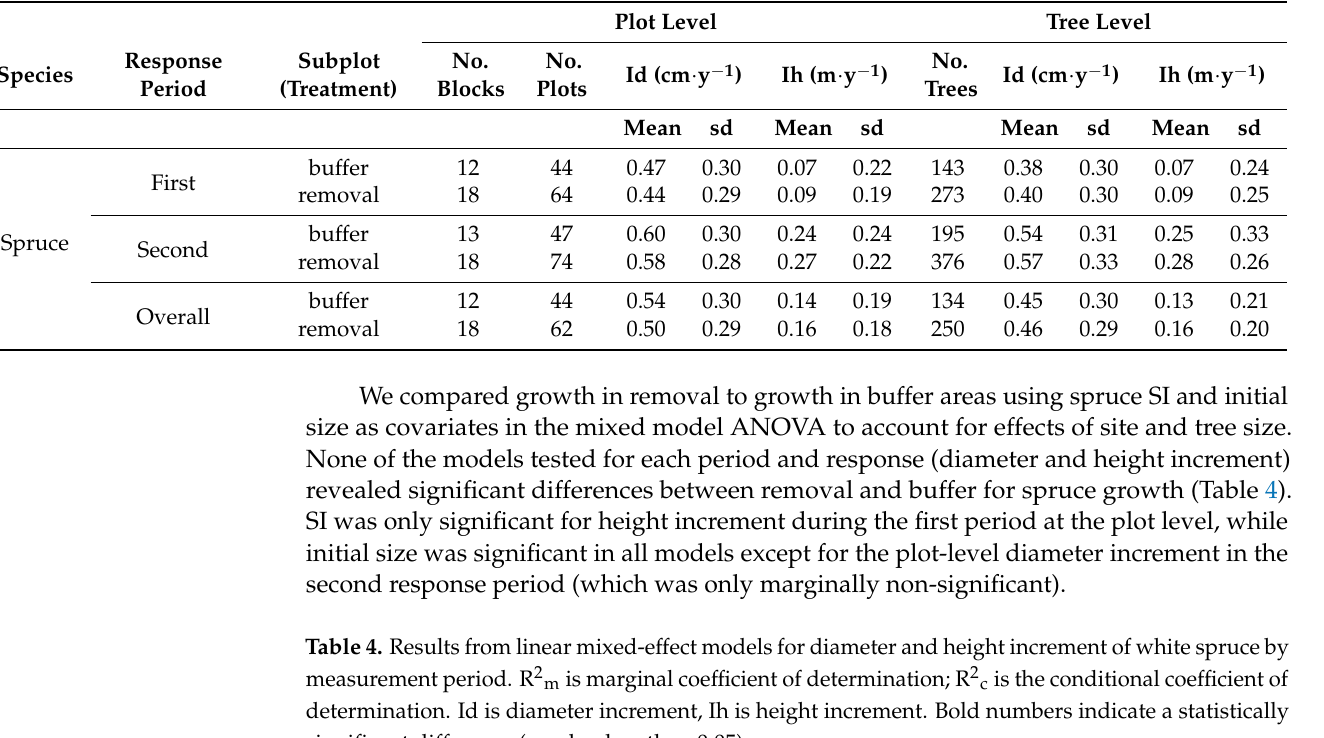
Table 3. Summary of spruce growth (trees ≥ 7.1 cm DBH) response at plot level and at tree level. Id = diameter increment. Ih = height increment. Note: Plots with no spruce trees were excluded from this analysis; the first response period between Measurements 1 and 2 ranged from 5 to 7 years; the second between Measurements 2 and 3 was 5 years. The overall response period between Measurements 1 and 3 ranged from 10 to 12 years.